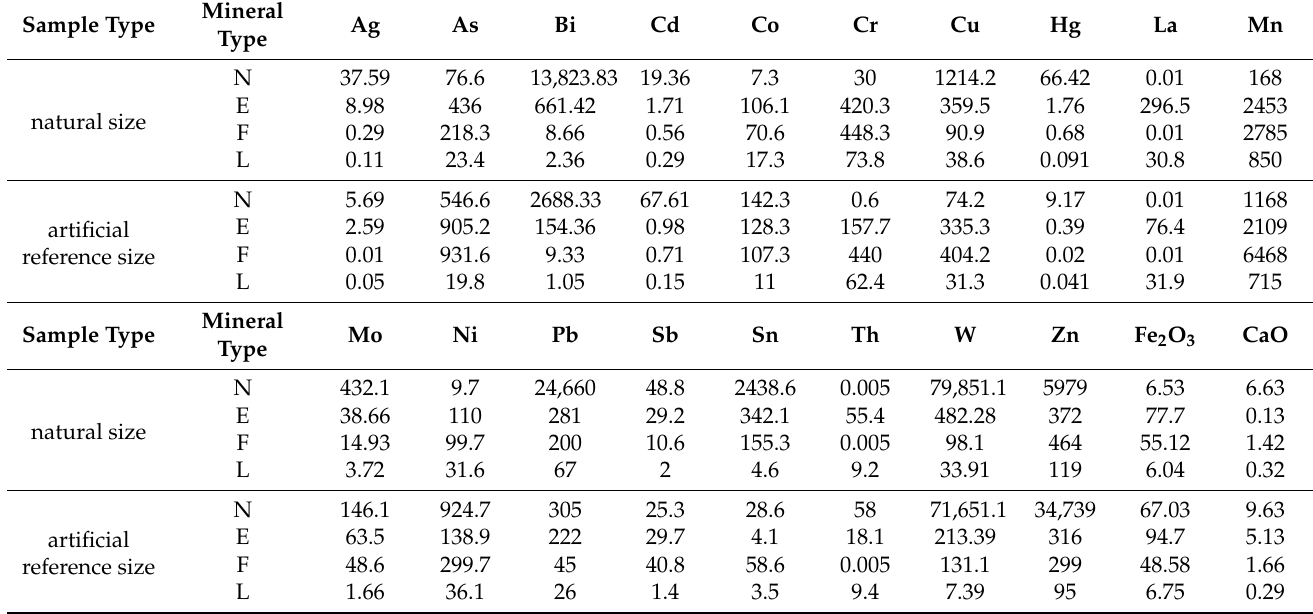
Table 3. Element concentrations in minerals in 0.177–0.125 mm fraction of stream sediments.